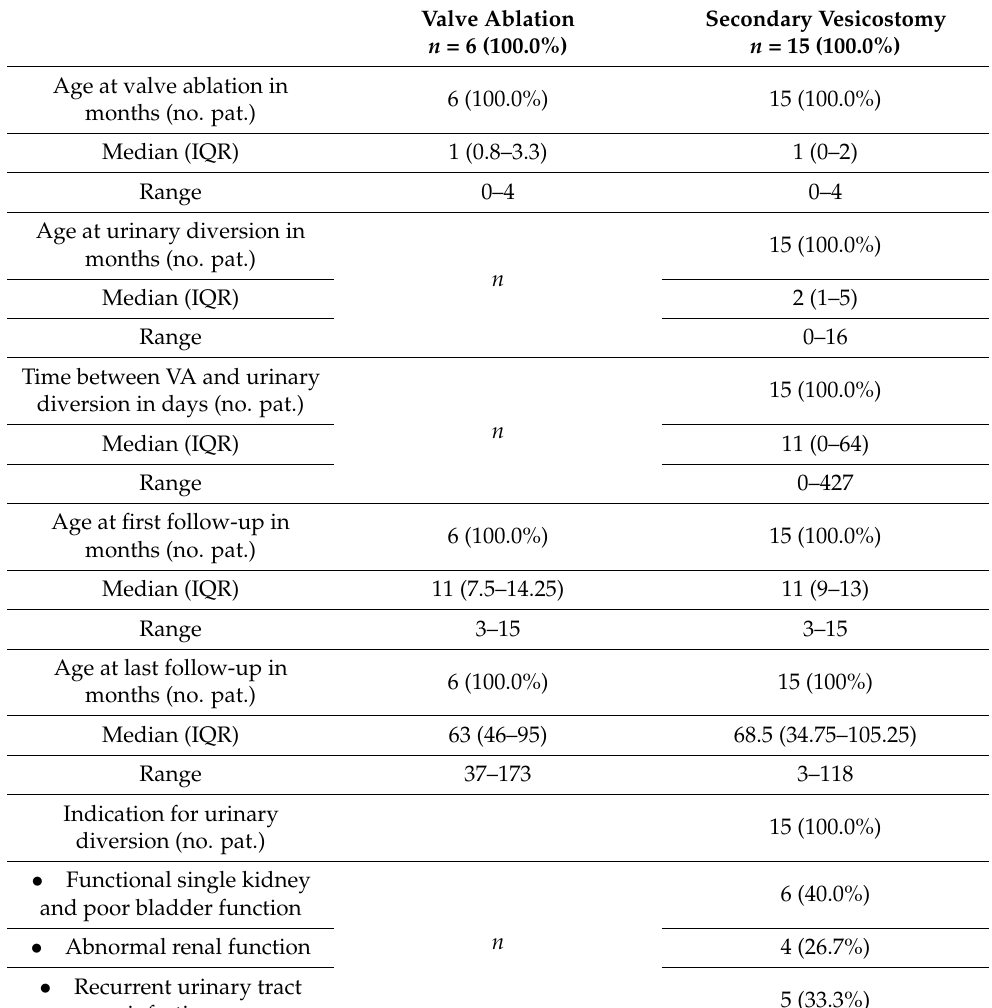
Table 1. Patients’